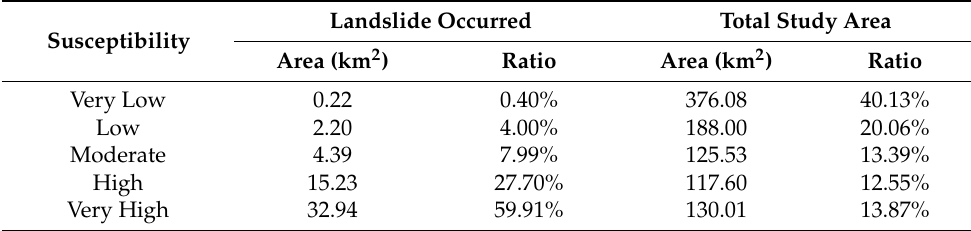
Figure 10. Landslide susceptibility map using the RF model. Table 6. Statistical results of the landslide susceptibility map.